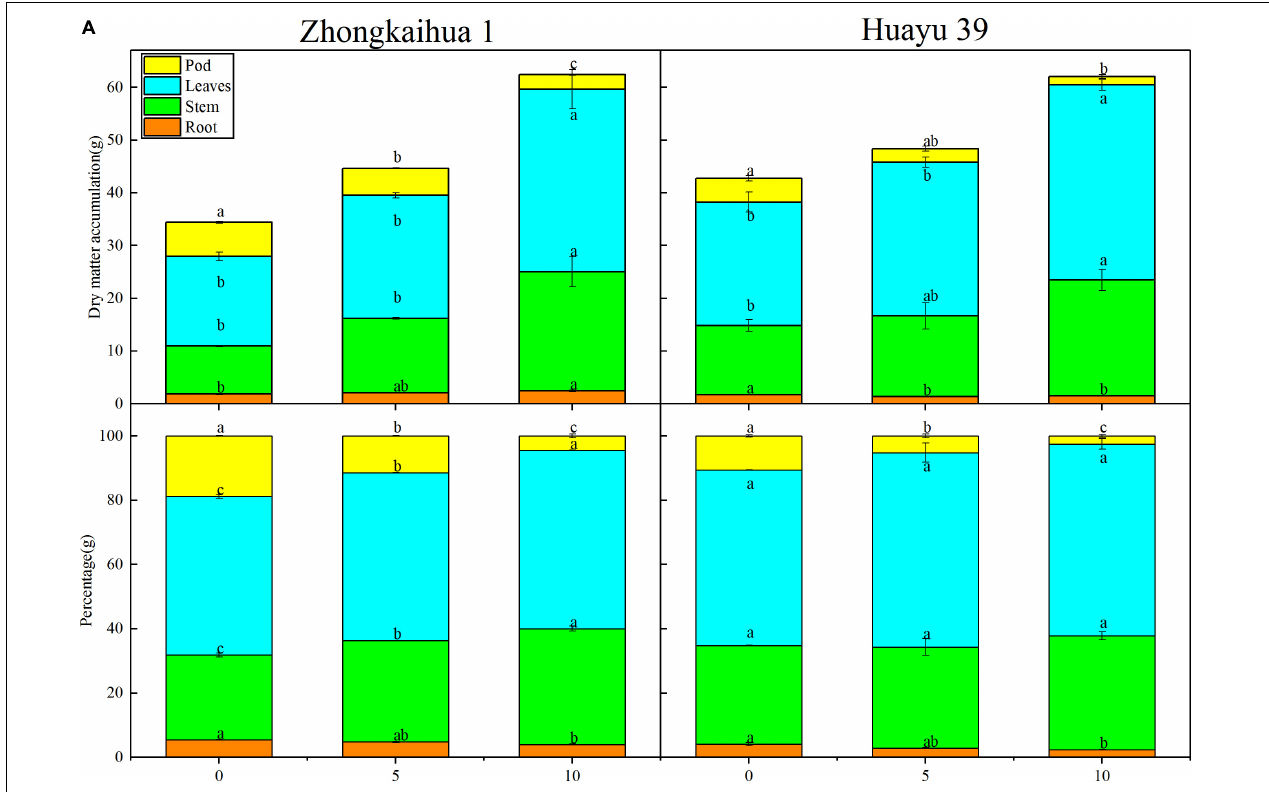
FIGURE 8 | Effects of waterlogging stress on the dry matter accumulation of peanut plant. (A) Effects of waterlogging on the dry matter accumulation of the root, stem, leaf, and pod of peanut plant and effects of waterlogging on the percentages of root, stem, leaf, and pod to the total dry matter per plant of peanut. Data represent mean ± standard error. Letters a and b after the value represent statistically significant differences ( p < 0.05) within a variety under different waterlogging treatments as determined by the least significant difference